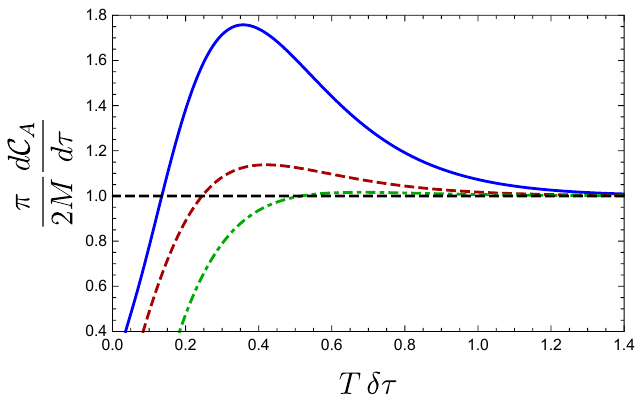
Figure 21 . Time derivative of complexity as a function of time for large hyperbolic black holes ( r h > L ) in d = 3 boundary dimensions for various values of the horizon radius | r h = 1 : 1 L (blue), r h = 1 : 5 L (dashed red), r h = 3 : 5 L (dot-dashed green). We present the plot as a function of the time coordinate in units of the thermal scale (cid:14)(cid:28) T = ( (cid:28) (cid:0) (cid:28) c ) T . We stress again that the complexity starts changing at (cid:28) c and each of the curves presented has a di(cid:11)erent value of (cid:28) c . For these parameters, the violation of the late time bound is clearly manifested.